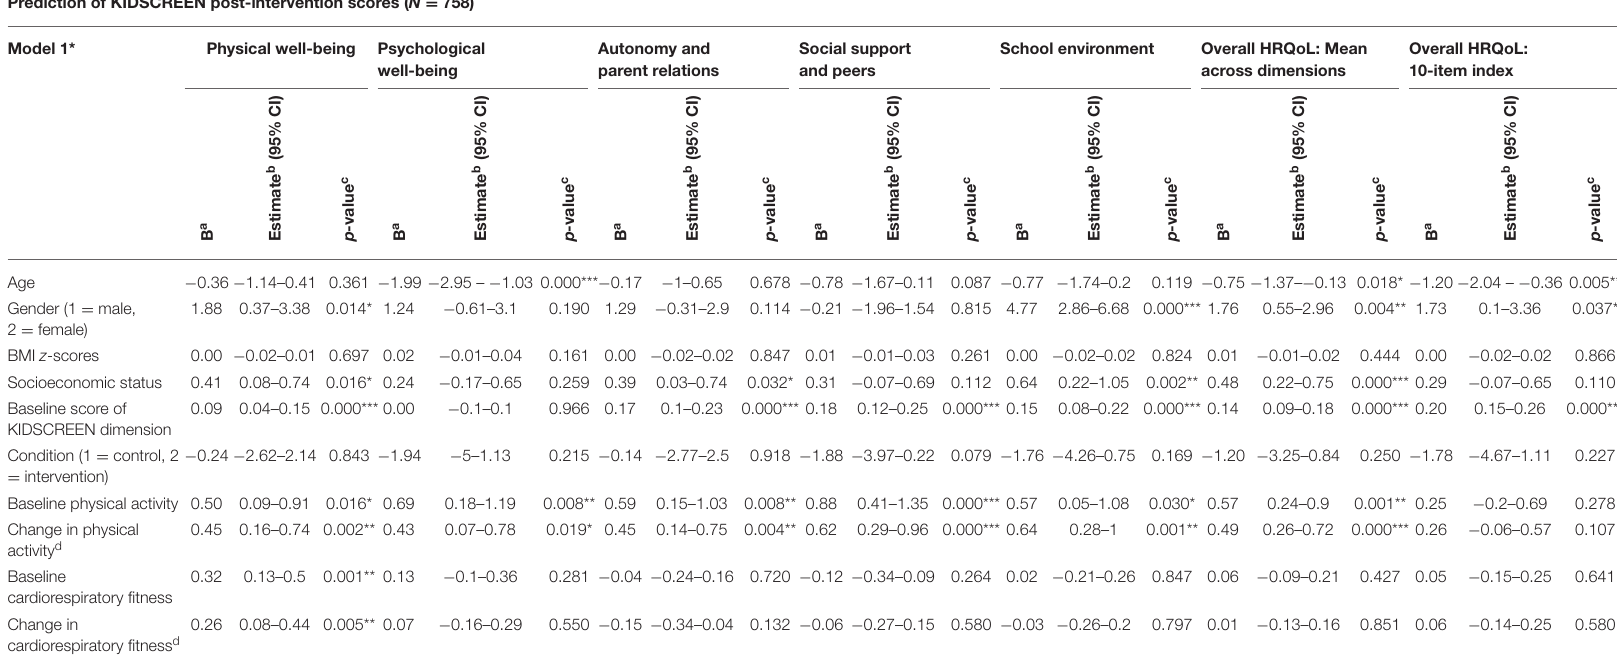
TABLE 3 | Multiple mixed linear regression analyses to predict post-intervention scores in children’s health-related quality of life. Prediction of KIDSCREEN post-intervention scores ( N = 758) Model